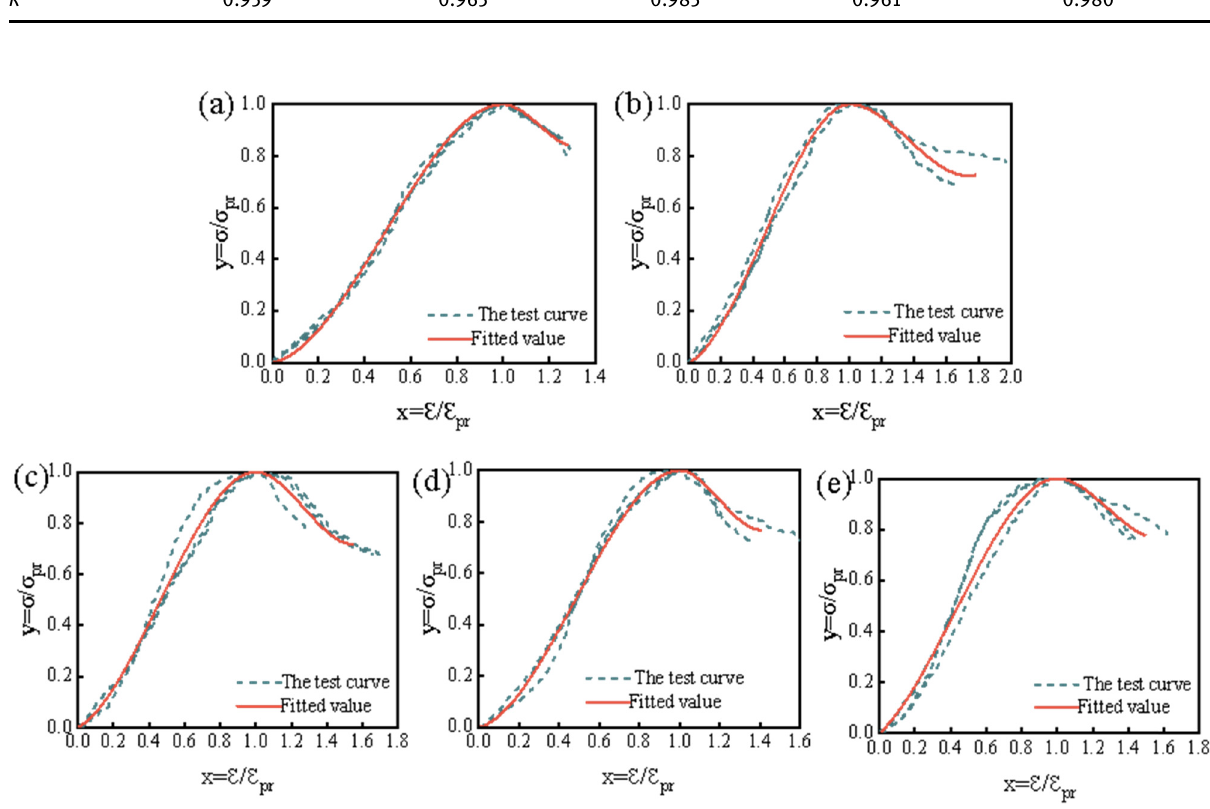
Figure 12: Comparison of experimental curve and fi tted curve: ( a ) yellow mud, ( b ) 0.5% straw, ( c ) 5% starch, ( d ) 5% cement, and ( e ) 7% epoxy